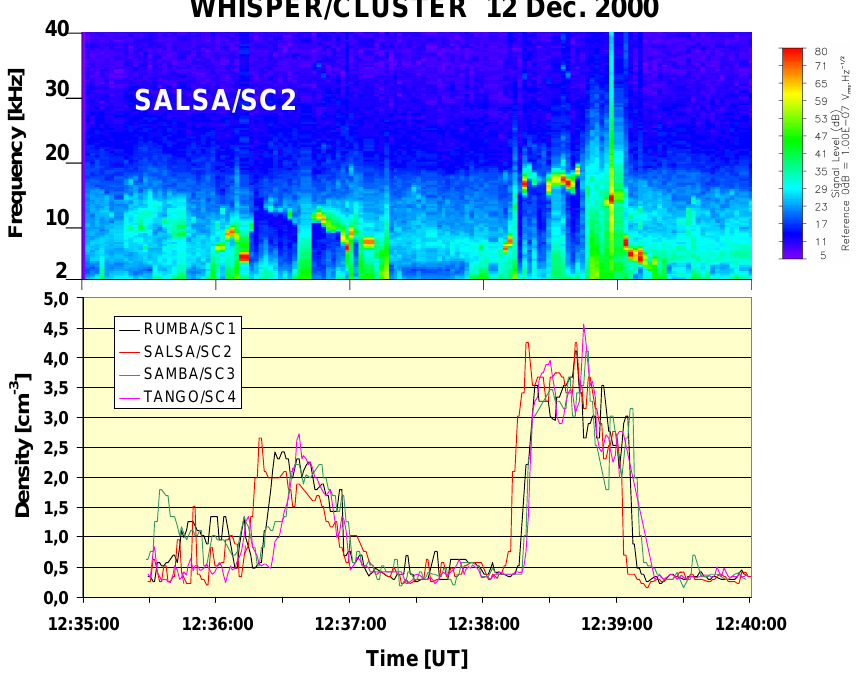
Fig. 13. Two successive plasma transfer events in the magnetopause boundary layer (17MLT, 28 ◦ latitude, 17.2 R E ). The bottom panel shows the density profiles derived from the four frequency/time spectrograms analogous to the one in the upper